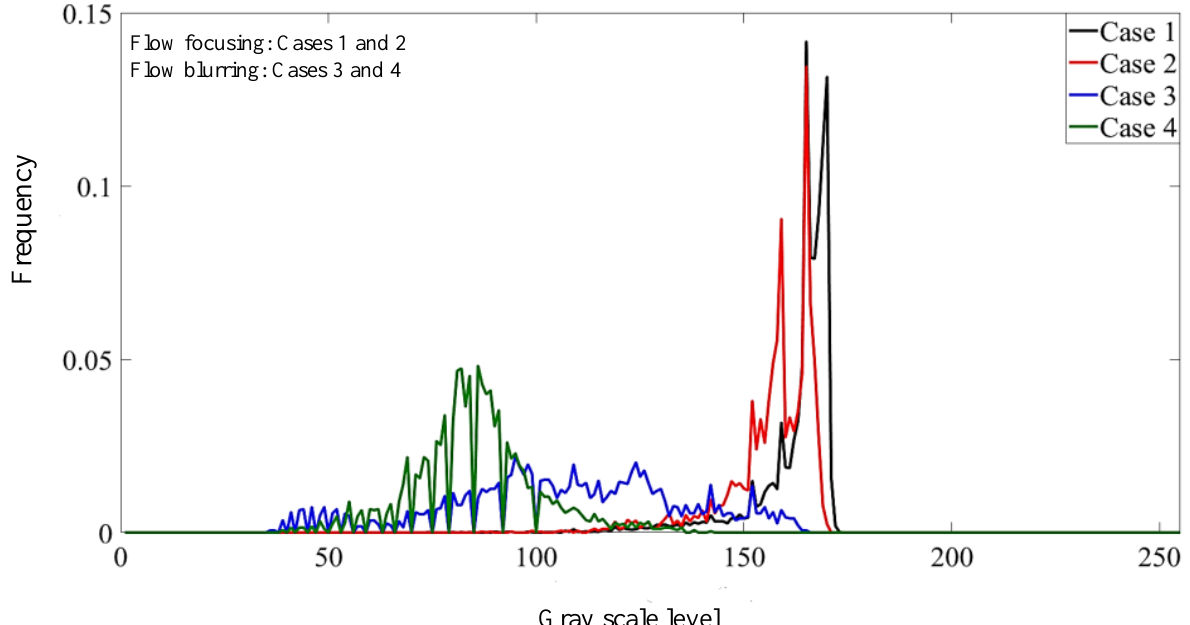
Figure 9. The gray distribution curves of the two-phase flow images under different tube-hole distances: the water flow rate, air flow rate and orifice diameter are 100 mL/min, 100 L/min and 5 mm, respectively. For cases 1 to 4, the tube-hole distance is 4 mm, 3 mm, 2 mm and 1 mm, respectively.